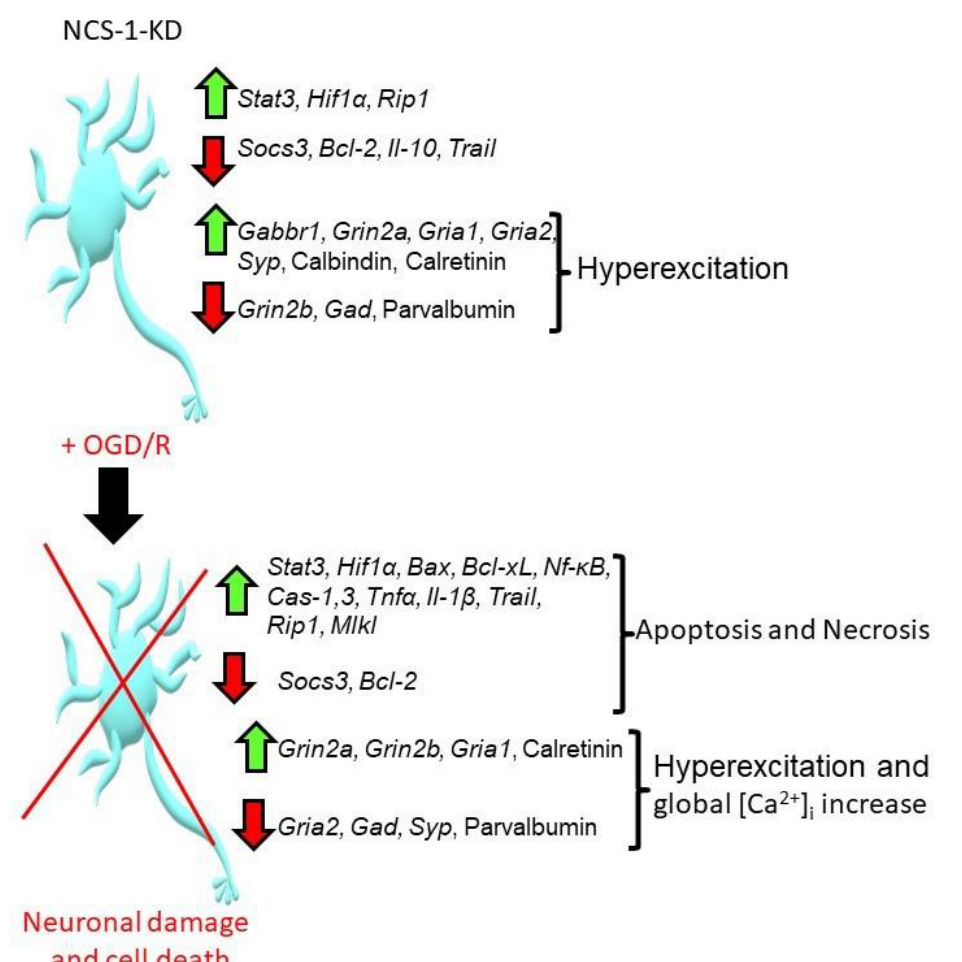
Figure 9. Summarizing scheme of the effects of NCS-1 knockdown in the cortical cells under the action of OGD/R. Abbreviations: Stat3 —signal transducer and activator of transcription 3, Hif1 α — action of OGD/R. Abbreviations: Stat3 — signal transducer and activator of transcription 3, Hif 1α — Hypoxia-inducible factor 1-alpha, Rip1 — Receptor interacting protein kinase 1 , Socs3 — Suppressor Hypoxia-inducible factor 1-alpha, Rip1 —Receptor interacting protein kinase 1, Socs3 —Suppressor of of cytokine signaling 3, Bcl-2 — B-cell lymphoma 2, Il-10 — Interleukin-10, Trail — TNF-related cytokine signaling 3, Bcl-2 —B-cell lymphoma 2, Il-10 —Interleukin-10, Trail —TNF-related apoptosis-inducing ligand, Tnfα — Tumor necrosis factor alpha, Gabbr1 — Gamma-aminobutyric